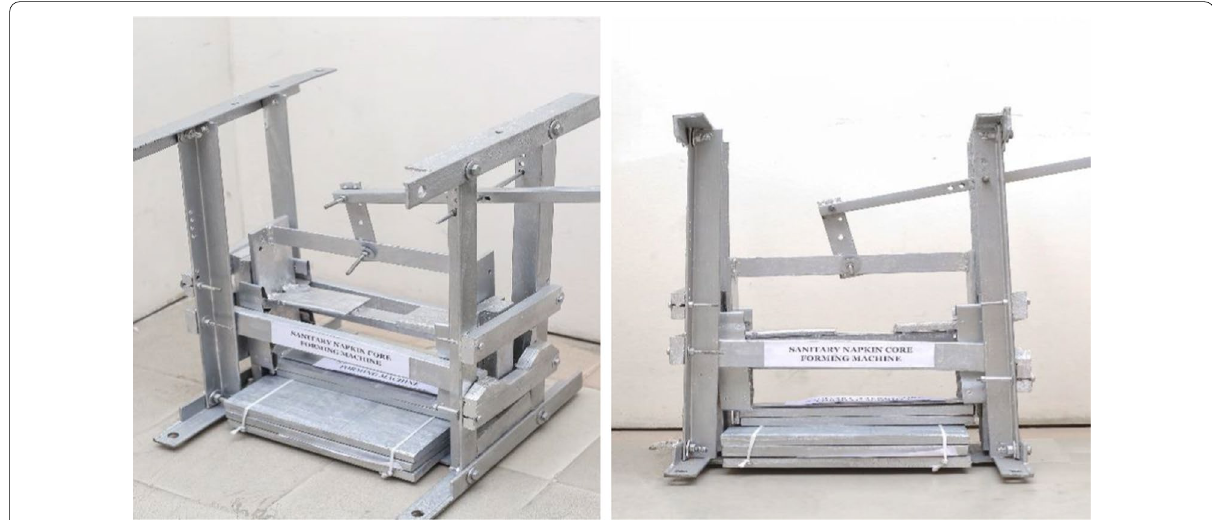
Fig. 2 Core forming machine fabricated for this